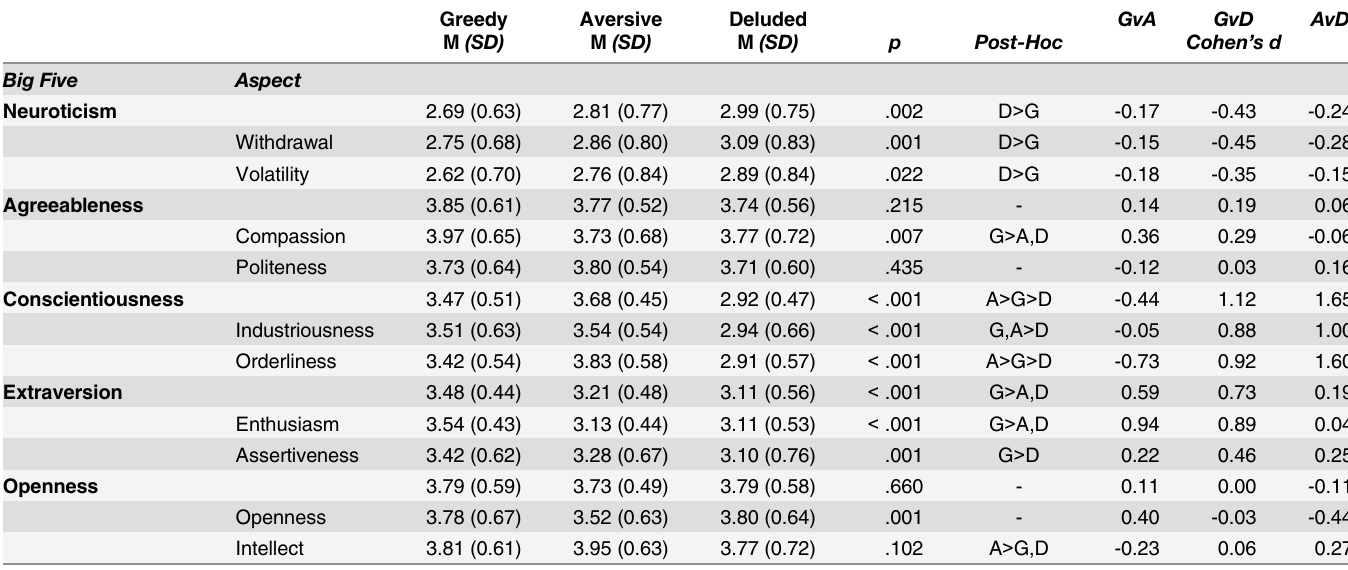
Table 4. Comparison of Groups in Sample 1 on Big Five Aspects and